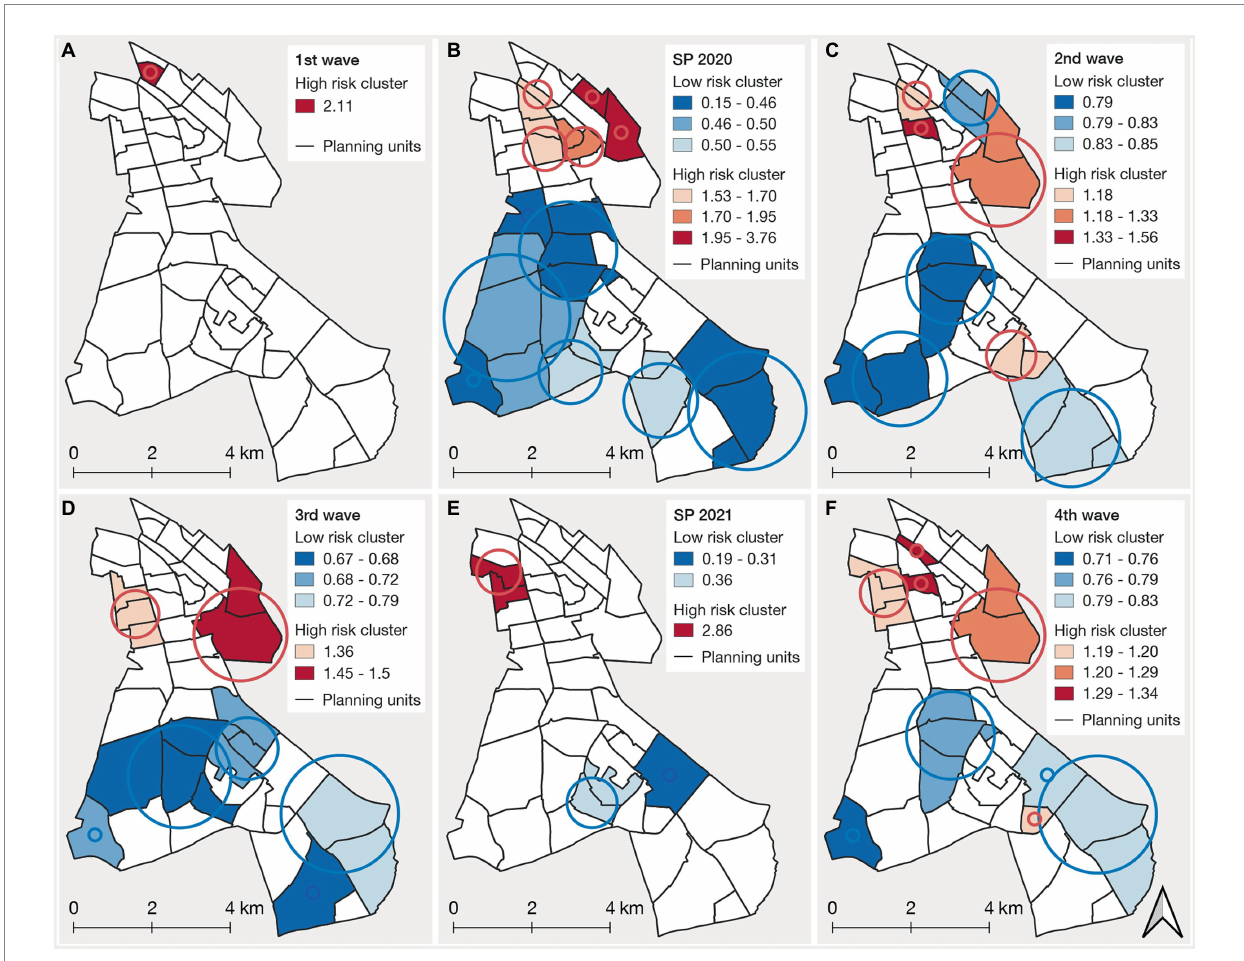
FIGURE 4 Spatial clusters of high-risk (red) and low-risk (blue) clusters of COVID-19 incidence across the six pandemic phases, including the four waves (A,C,D,F) and two summer plateaus (SP) (B,E) during the study period. The buffers represent the circular windows that were detected as significant spatial clusters. The size was determined by the centroids of the planning units located within the